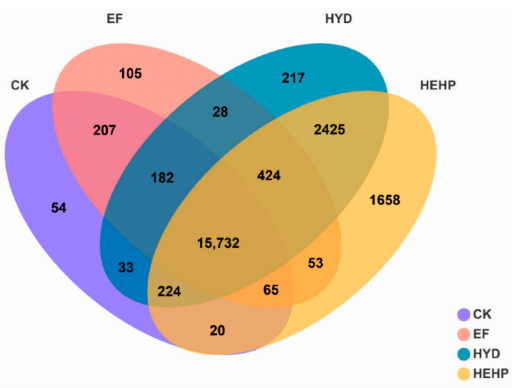
Figure 5. Venn diagram showing specific and overlapping identified genes among all the